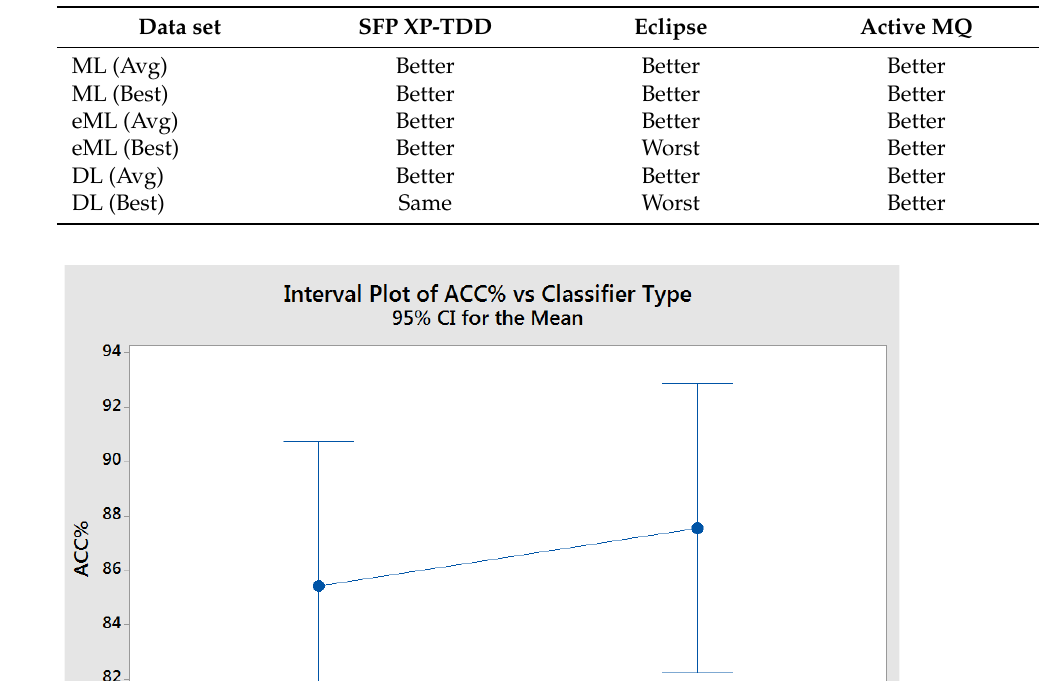
Table 12. Overall Evaluation of Experimental Results based on ACC.